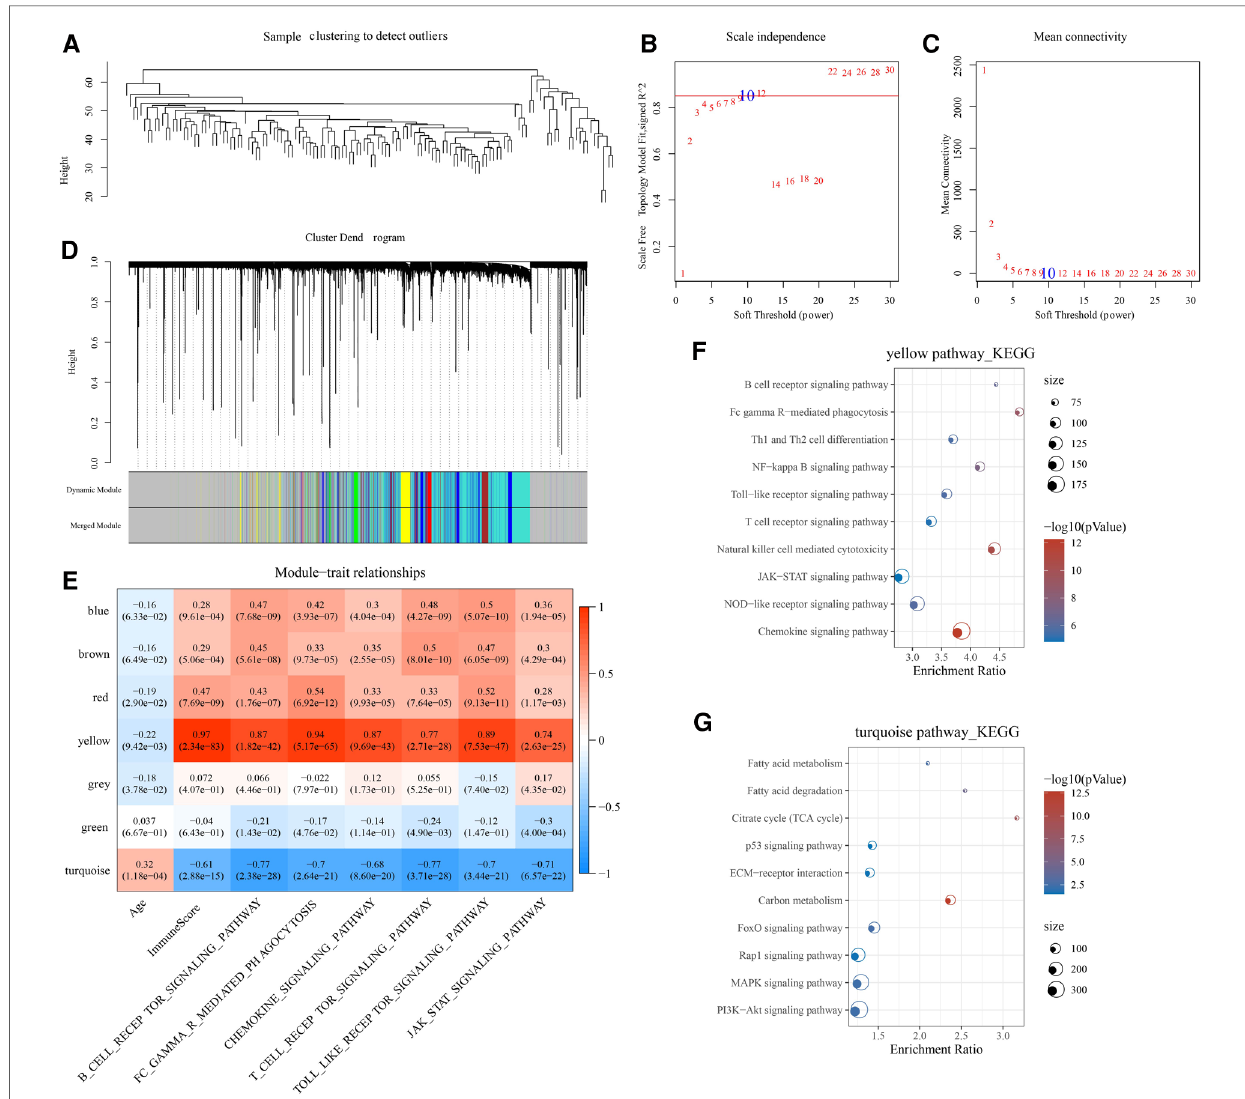
FIGURE 4 WGCNA construction. ( A ) Hierarchical clustering tree for each sample in the GSE57338 cohort. ( B ) The scale-free fi t index for various soft-thresholding powers. ( C ) The mean connectivity for various soft-thresholding powers. ( D ) Genes are divided into different modules by hierarchical clustering, and different colors represent different modules. ( E ) Correlation of module eigenvectors of modules with age and immunity. ( F ) Functional annotation of yellow module genes. ( G ) Functional annotation of turquoise module